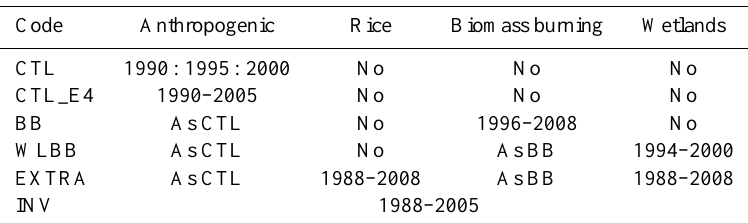
Table 2. Methane emission scenarios, indicating which components have interannual variations over different periods. A mean seasonal cycle is used outside the listed periods.